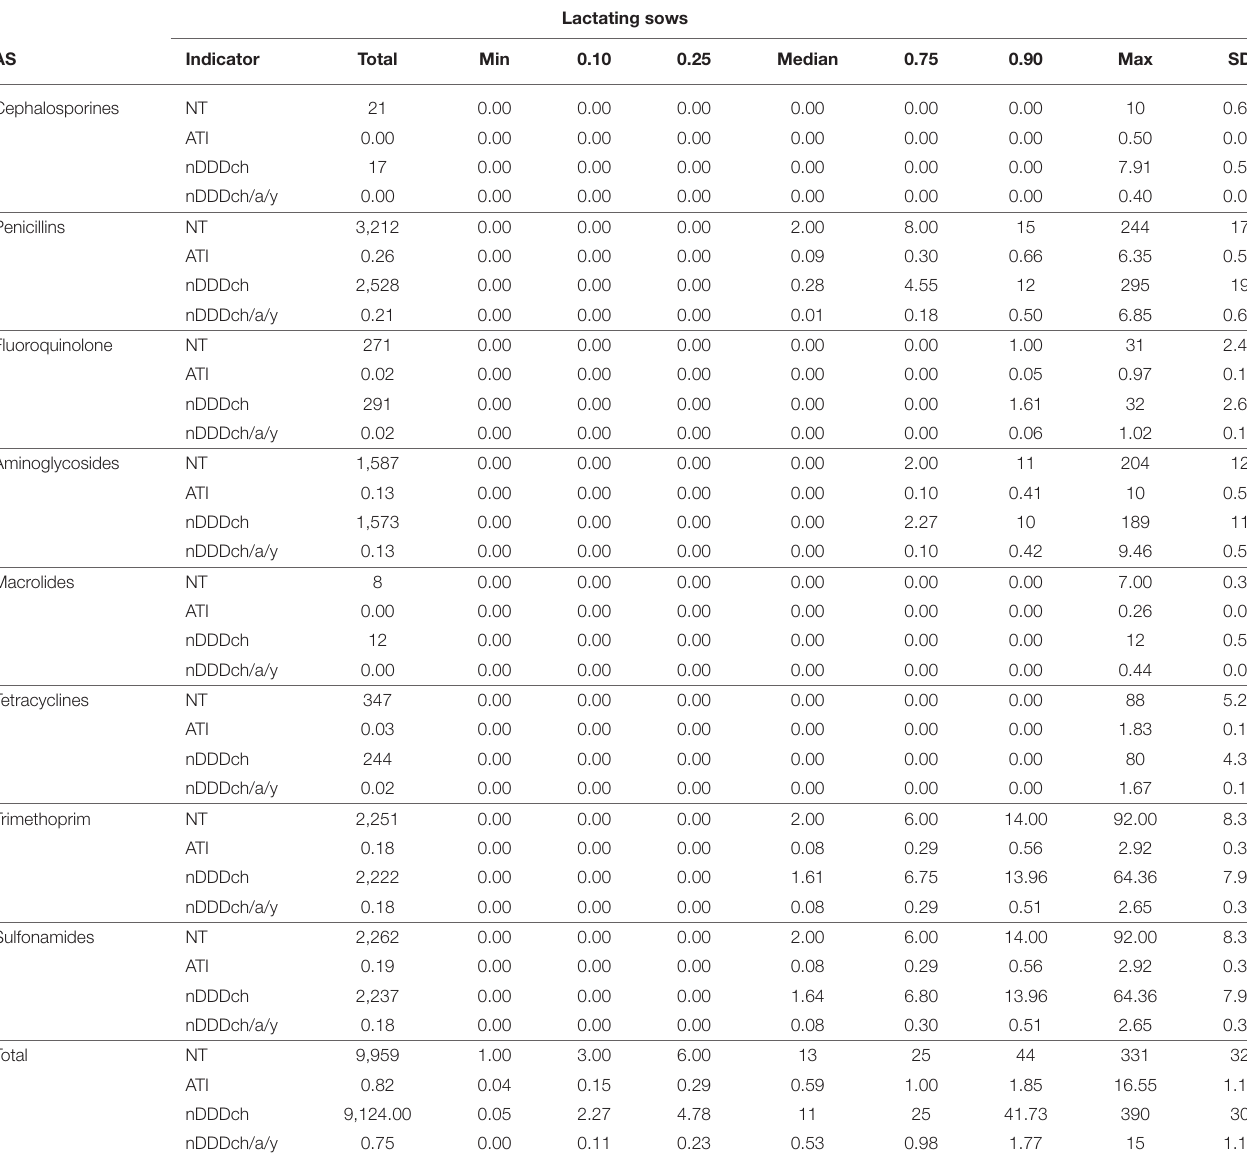
TABLE 5 | Total, minimum (min), median, maximum (max), 10% (0.1), 25% (0.25), 75% (0.75), 90% (0.9) percentiles and standard deviation (SD) of AMU in lactating sows of the study farms measured using the indicators NT, ATI, nDDDch and nDDDch/animal/year (nDDDch/a/y) displayed by active substance